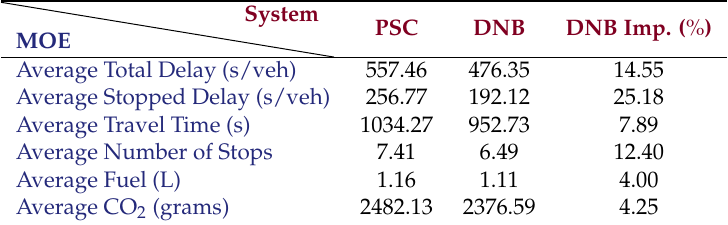
Table 8. Average MOEs and the (%) improvement using DNB controller over PSC controller (100% Demand). PSC DNB MOE